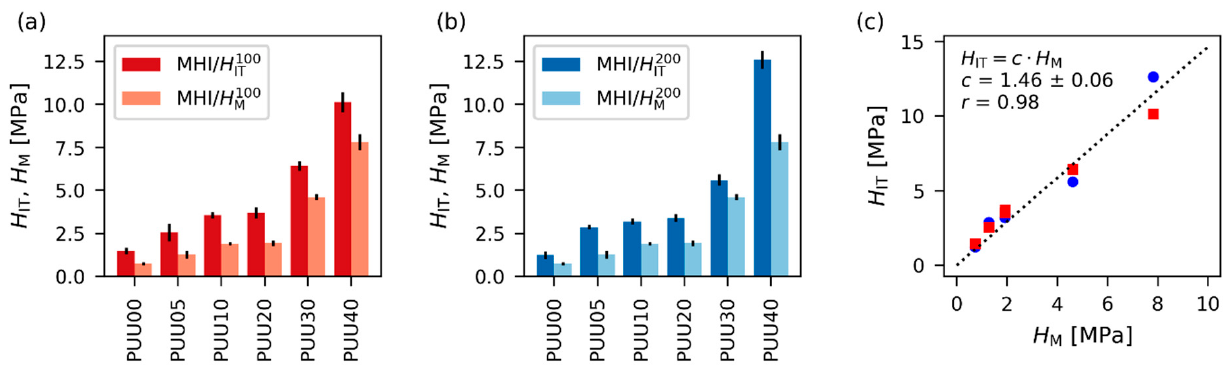
Figure 7. MHI results illustrating the correlations between indentation hardness ( H IT , evaluated in terms of the O&P theory) and universal hardness ( H M , also known as Martens hardness, whose evaluation is independent of the O&P theory). The subplots show: ( a ) comparison of H IT and H M values for a maximum load of 100 mN; ( b ) comparison of H IT and H M values for a maximum load of 200 mN; and ( c ) the correlation between all measured H IT and H M values. In the last plot ( c ), the value of r represents Pearson’s correlation coefficient, while the red squares and blue circles represent values measured at 100 mN and 200 mN, respectively.